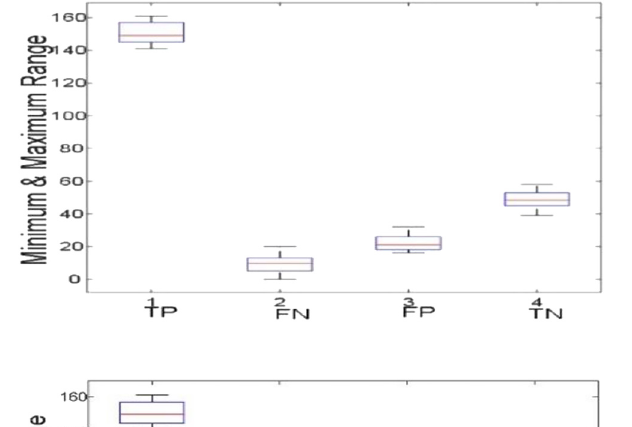
Figure 15: Boxplot (TLBO-ELM).